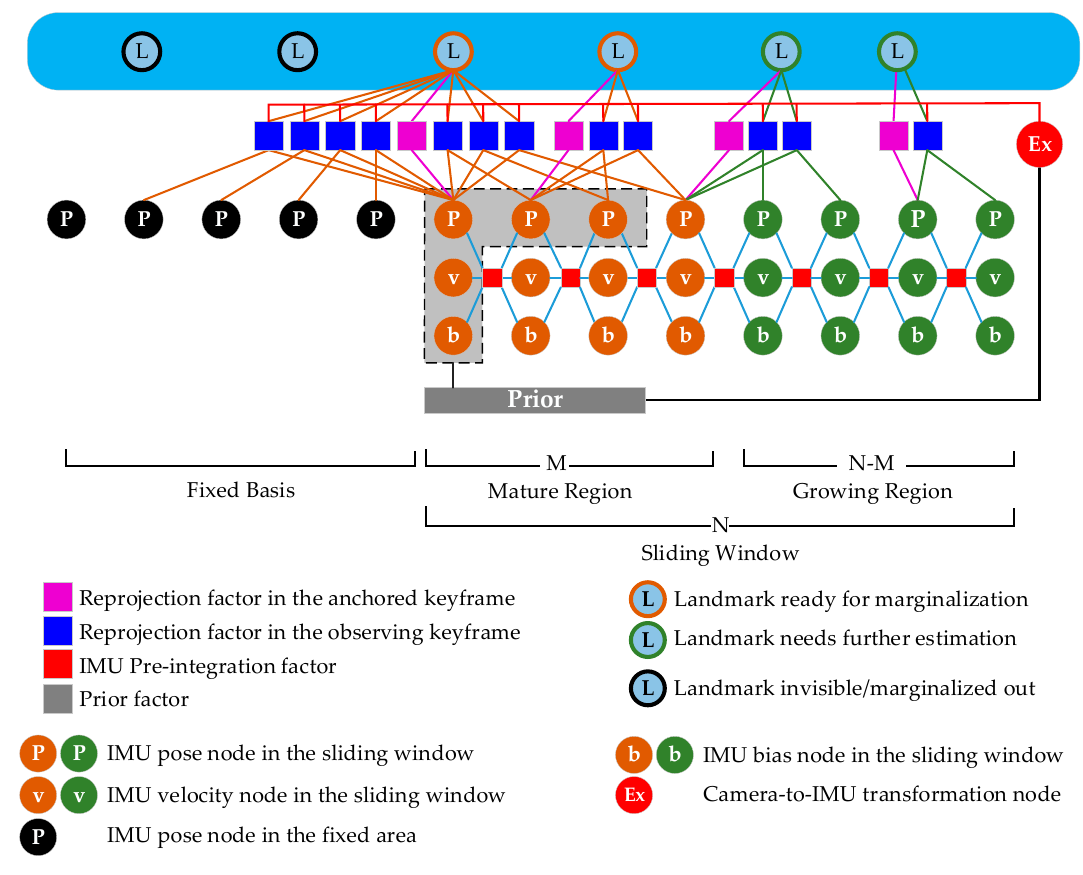
Figure 1. The structure of the hybrid sliding window optimizer.